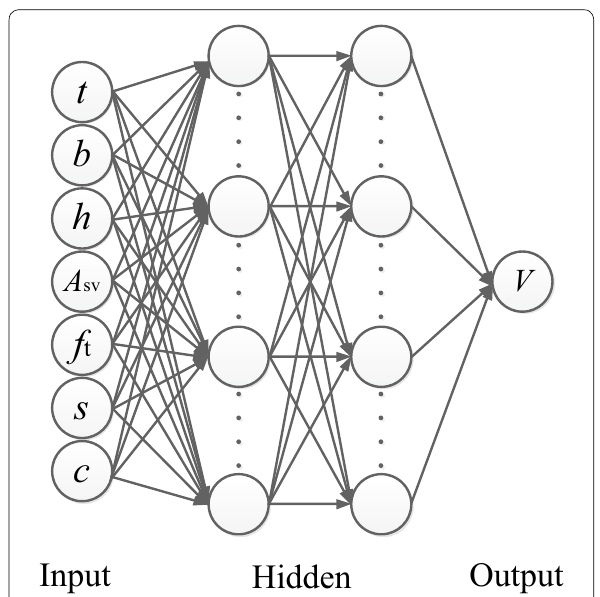
Fig. 6 Construction of BP neural network